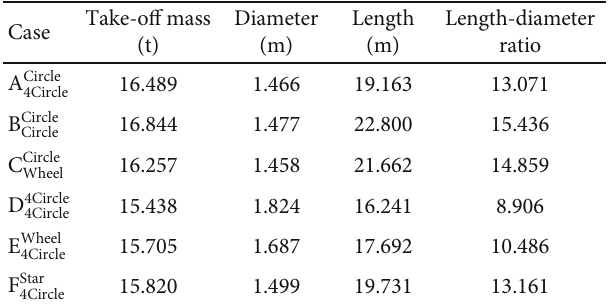
Figure 11: Comparison of structures with di ff erent grain shapes. Table 7: Take-o ff mass and overall dimension of di ff erent